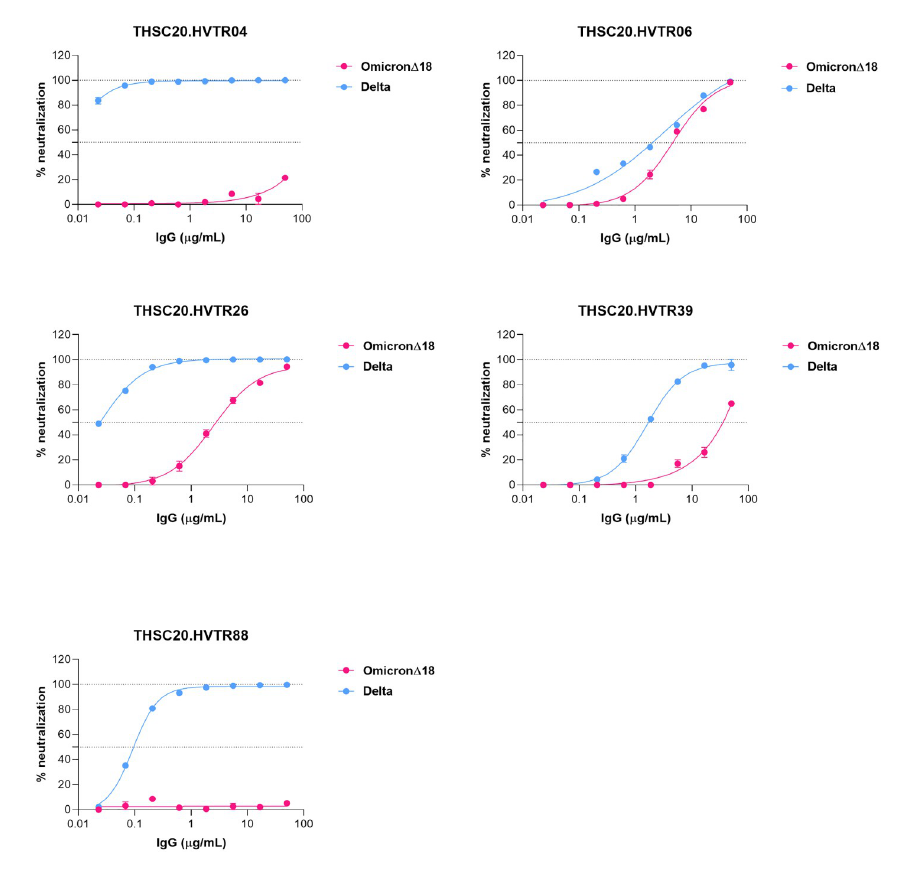
Fig 3. Neutralization potential of isolated monoclonal antibodies against Omicron. Neutralization of pseudovirus expressing Omicron spike by all the five newly isolated mAbs was carried out as described above. Average of three independent experiments with each concentration response tested in duplicate were used to prepare the dose response curves. Values shown are mean with SEM.